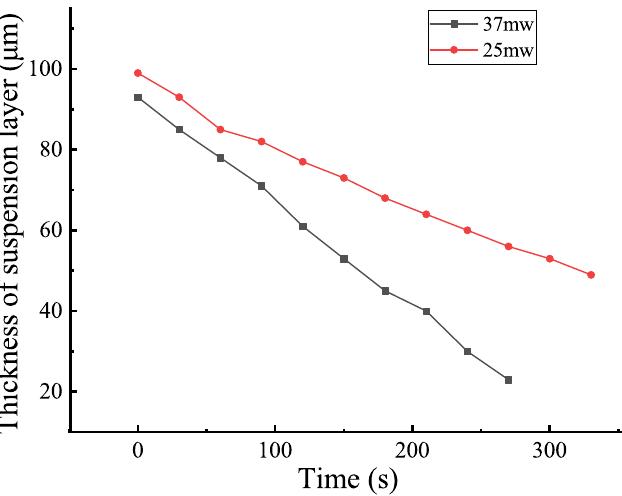
Figure 5. Thickness of the suspension layer as a function of illumination